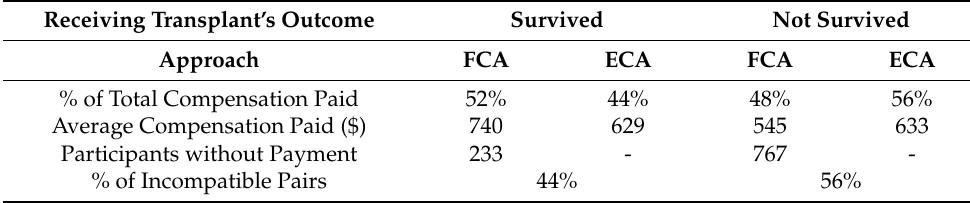
Table 7. Results of cost-apportionment